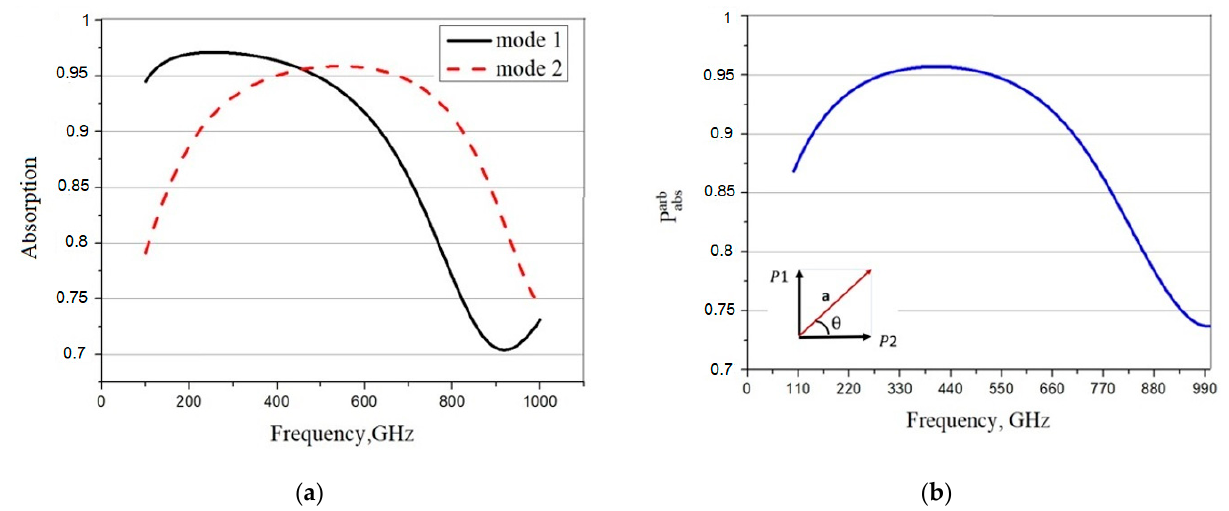
Figure 6. ( a ) Pabs of mode#1 and mode#2, ( b ) Pabs 𝑎𝑟𝑏 of the unit cell for arbitrary polarization.